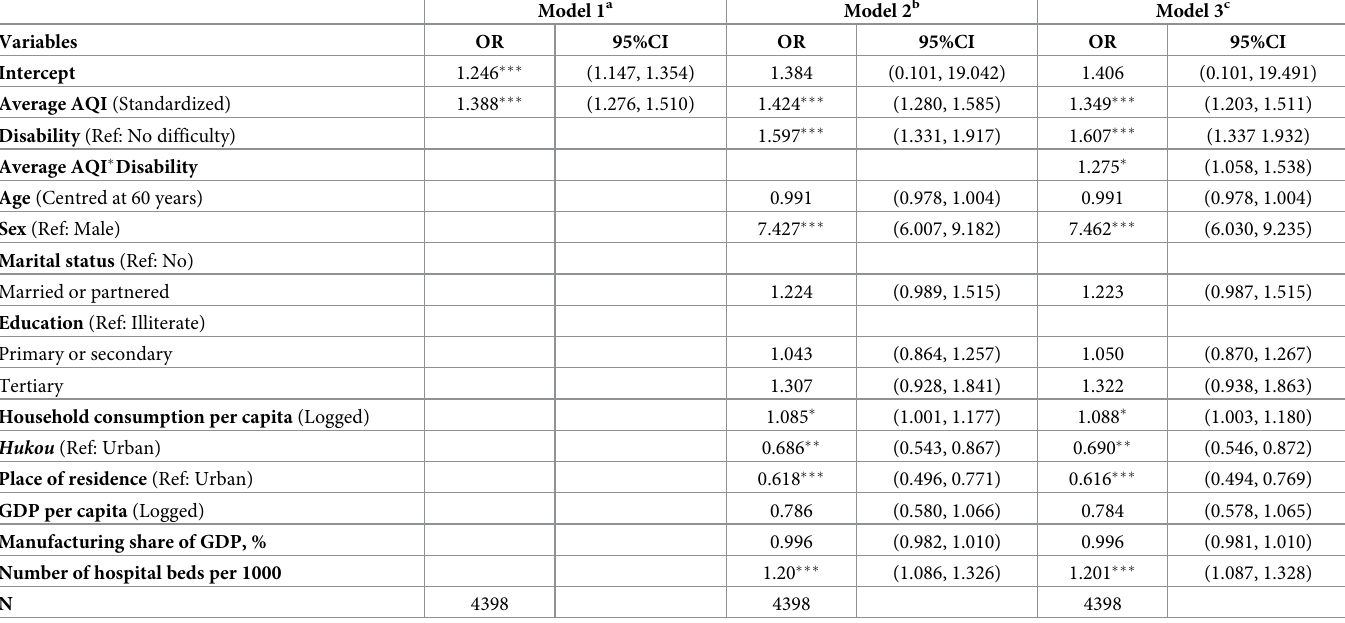
Table 3. Regression results (Odds ratio and 95%CI) for the association between air pollution and abdominal obesity among older people from the China Health and Retirement Longitudinal Study 2015.